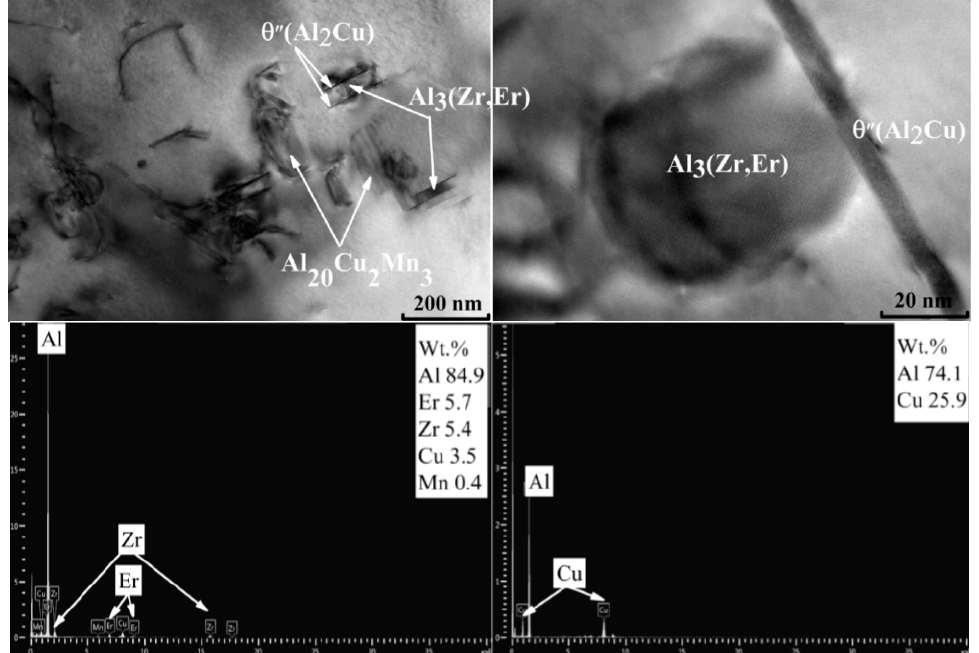
Figure 4. Microstructure of the annealed alloy at 605 °C for 3 h and the aged alloy at 210 °C for 5 h, and the EDX spectra from Al 3 (Zr,Er) and θ ’’(Al 2 Cu) particles (TEM). The ingot of the investigated alloy was quenched at 605 °C after homogenization treatment for 3 h, rolled to a 1 mm thick sheet, and annealed at different temperatures. The HV vs. temperature and time curves of the annealed alloy after rolling are shown in Figure 5. Figure 5a demonstrates the evaluation of HV after 1 h of annealing at 100–550 °C in comparison with that of the Al-6Cu-4.05Er [19] and Al-4Cu-2.7Er-0.3Zr [30] alloys. The investigated alloy has a high hardness due to the addition of manganese. Two processes can take place during the annealing of the as-rolled investigated alloy: softening and strengthening. Softening during low temperature after rolling proceeds due to a decrease of the dislocation density and formation of the substructure with low angular boundaries. The fine particles of the Al 3 (Zr,Er) and Al 20 Cu 2 Mn 3 phases retard softening. Strengthening is promoted due to aging processes and the nucleation of metastable θ ’’(Al 2 Cu) precipitates. A deformed structure with a high density of dislocations and vacancies accelerates strengthening. The HV peak was found after 1 h of annealing at 150 °C (Figure 5a) and after 2 h of annealing at 150 °C (Figure 5b). Strengthening by θ ’’(Al 2 Cu) precipitates has a larger effect on material hardness than do softening processes at 150 °C. The hardness decreases by increasing the annealing temperature above 150 °C (Figure 5a). The hardness peak shifted to 0.5–1 h by increasing the annealing temperature up to 180 °C (Figure 5b). Softening has the largest effect on hardness at temperatures higher than 180 °C (Figure 5b). The recrystallization temperature of the alloy is in the range of 350–400 °C. A non- recrystallized grain structure was found after 1 h of annealing at 350 °C (inserted image in Figure 5a). The average grain size increased from 7.3 to 10.6 µm by increasing the annealing temperature from 400 to 550 °C (inserted images in Figure 5a).